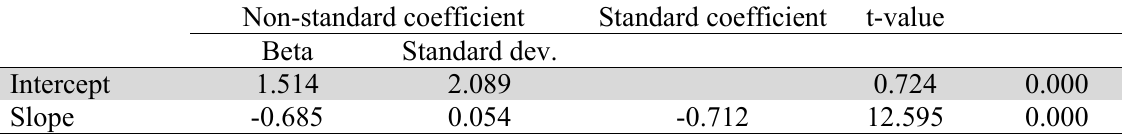
Non-standard coefficient Standard coefficient